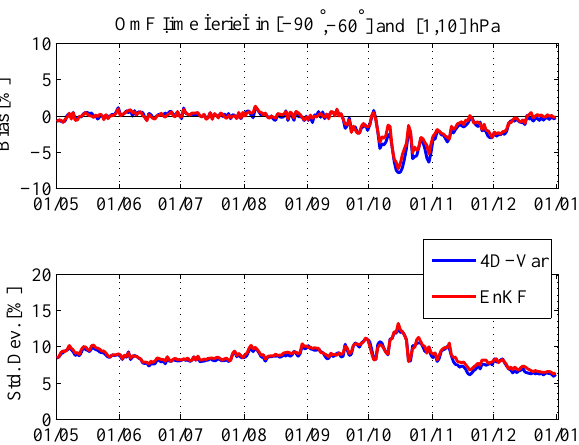
Figure 6. As Fig. 5 but between 10 and Fig.6: AsFig. 5butbetween10and100hPa.